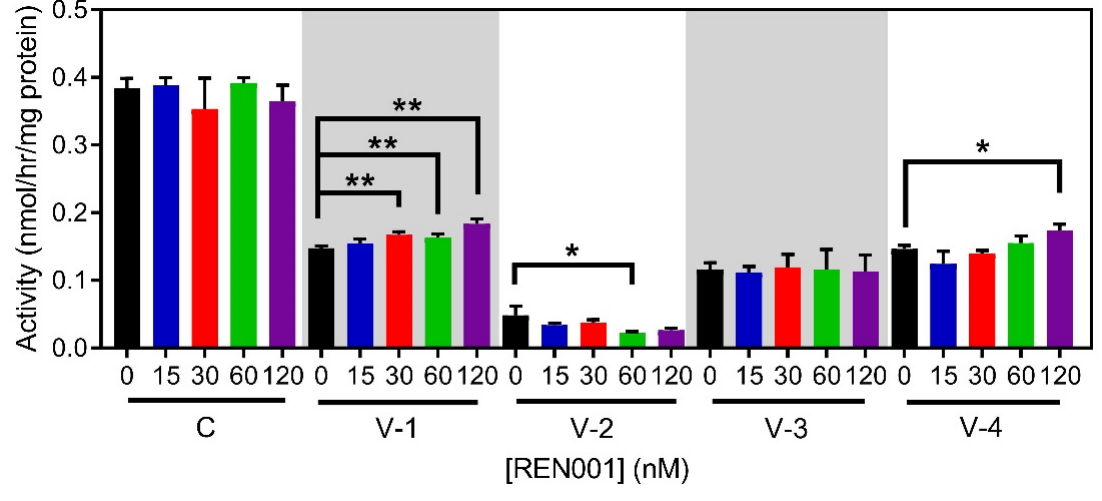
Figure 3. Fatty acid oxidation (FAO) flux in control and VLCAD-deficient fibroblasts treated with REN001 for 48 h. Bars represent mean and standard deviations in duplicate assays. * p < 0.05, ** p < 0.01, compared to values at 0 nM treatment (n = 3 for all assays; t -test for unpaired samples).